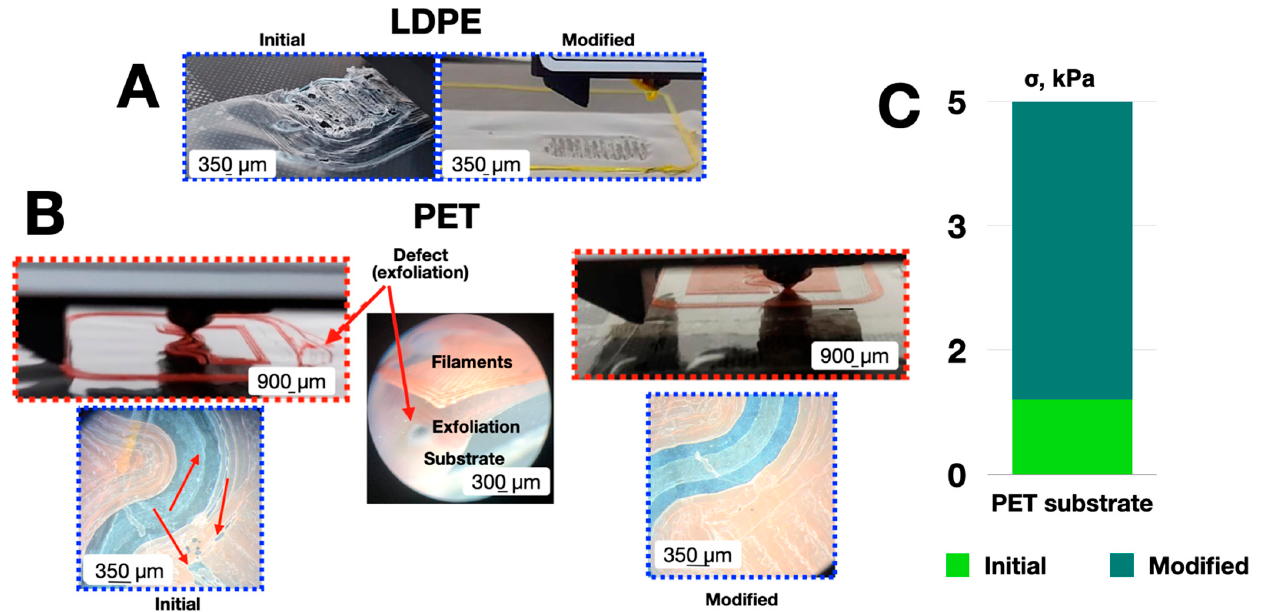
Figure 8. Optical quality control of microdevice elements’ reproduction on the initial and modified LDPE—( A ) and PET—( B ) (printing defects are indicated by red arrows); the PLA filament peel strength—( C ).